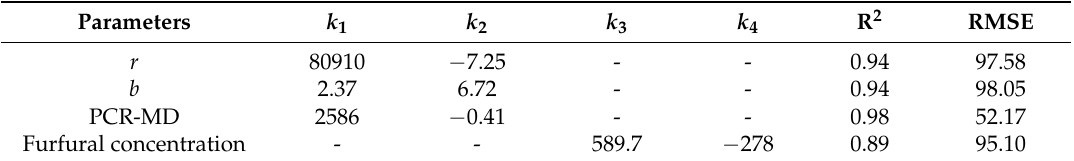
Table 1. Comparison of fitting parameters ( k 1 , k 2 , k 3 , and k 4 ), goodness of fit (R 2 ), and mean square error